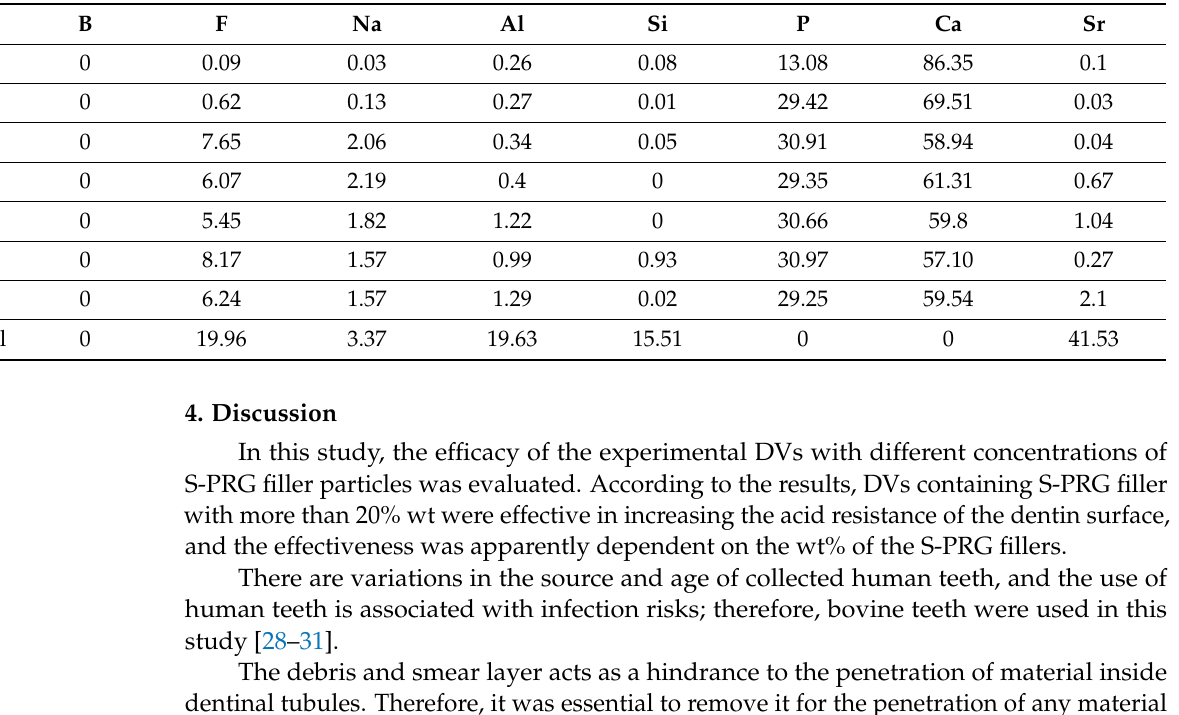
Table 2. Percentile distribution of filler elements inside and around DTs after application in relation to Ca and P obtained on analysis by an EDS. Abbreviations: DTs; dentinal tubules, B; boron, F; fluoride, Na; sodium, Al; aluminum; Si; silicon, P; phosphorous, Ca; calcium, and Sr;